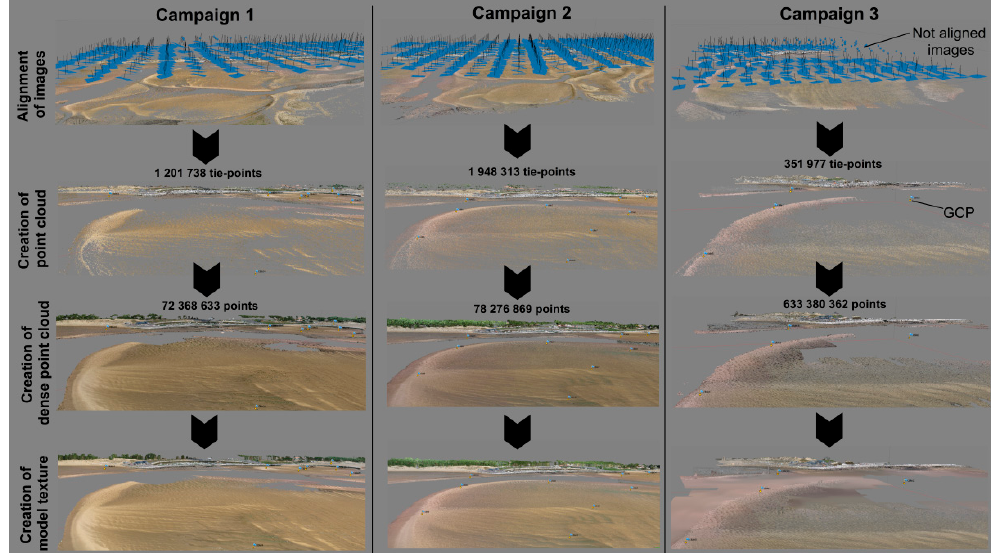
Figure 5. Illustration of the different stages of the photogrammetric process at the flood delta sand bank: alignment of images, creation of point cloud, creation of dense point cloud, creation of model texture.